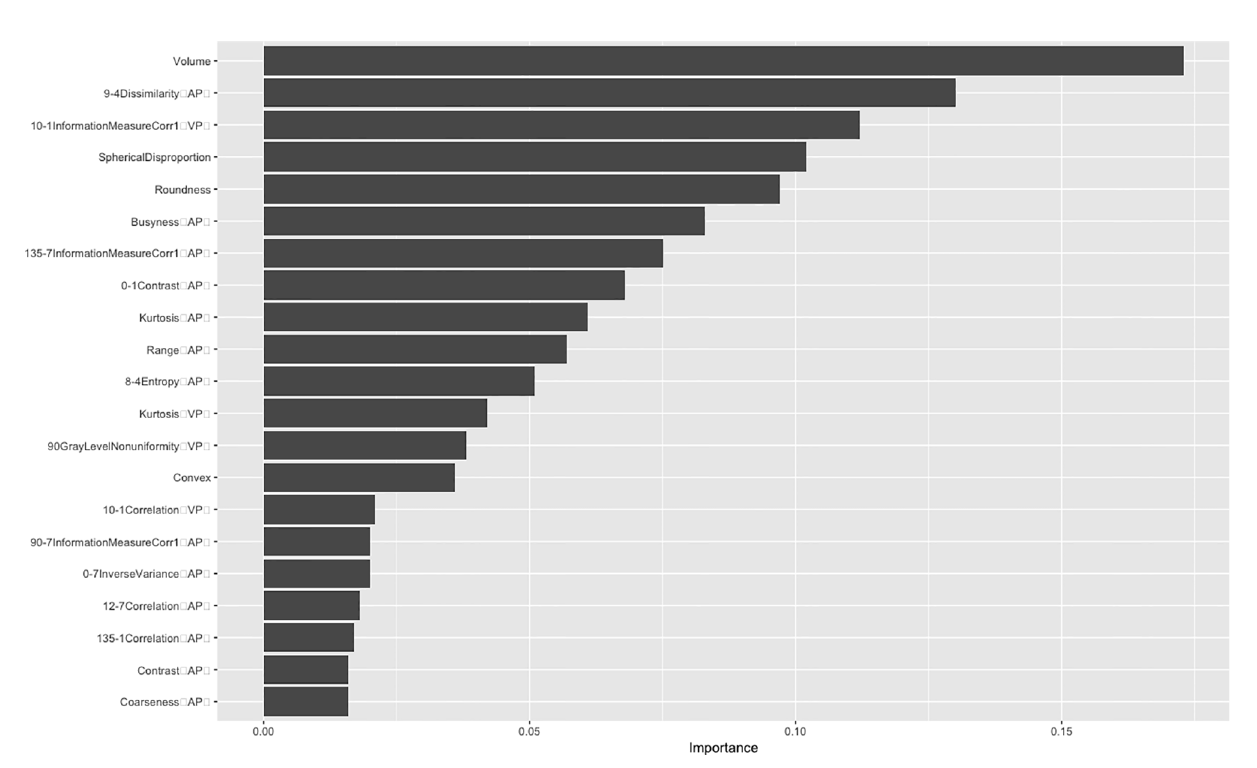
FIGURE 2 | The importance of radiomics features. AP, arterial phase; VP, venous phase.